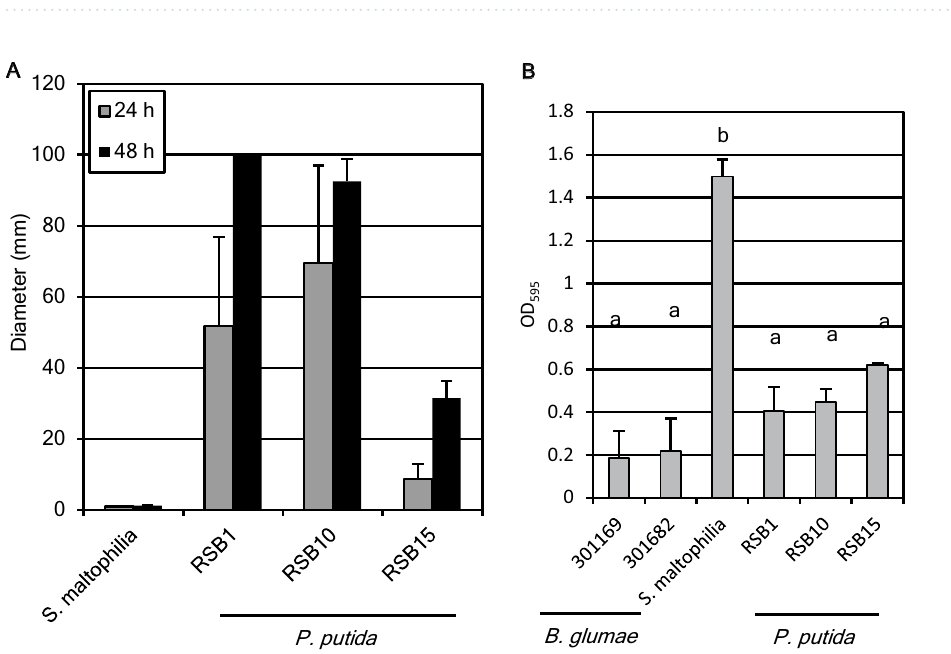
Figure 5. Characterization of RSBs. ( A ) Size of swarming (n = 5). ( B ) Biofilm formation assays of RSBs and B. glumae (n = 3). Statistical significance was subsequently determined through a TukeyHSD test (R software). Results are representative of two